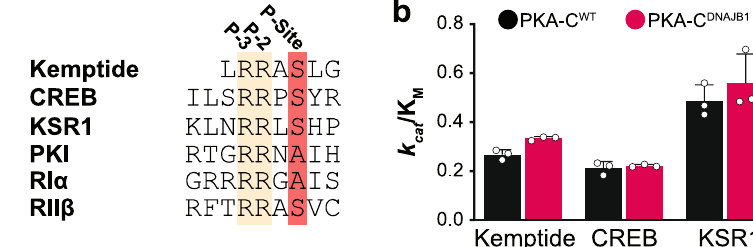
Fig. 2 Attenuation in binding cooperativity does not in fl uence phosphoryl transfer. a Comparison of the substrate recognition sequences of substrates Kemptide, CREB, and KSR1, regulatory subunits, RI α and RII β , and endogenous inhibitor, PKI. b Bar graph displaying the catalytic ef fi ciencies ( k cat / K M ) of PKA-C WT and PKA-C DNAJB1 towards Kemptide, CREB, and KSR1. Errors were calculated from triplicate measurements. All kinetics parameters